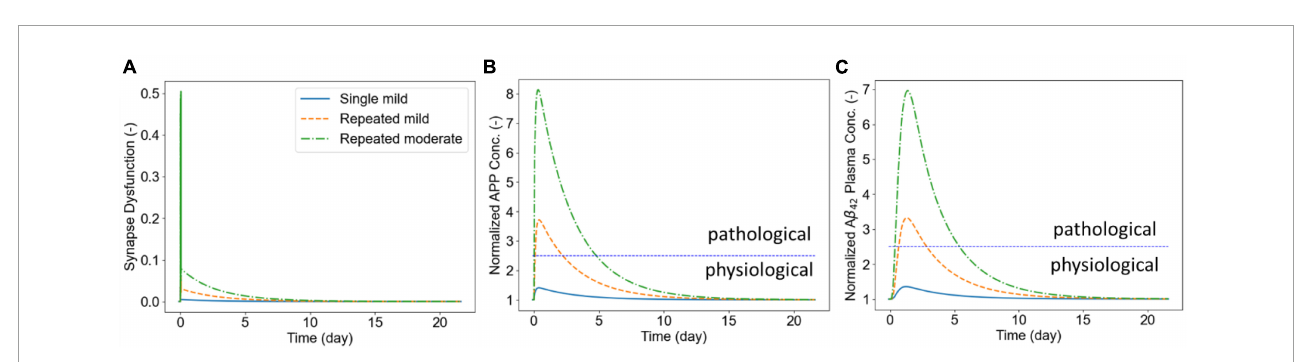
FIGURE8 Panel (A) shows the synaptic dysfunction. Panel (B) shows the elevation in APP following the exposure to LLBs. Panel (C) shows the plasma concentrations of Aß 42 following exposure to repeated